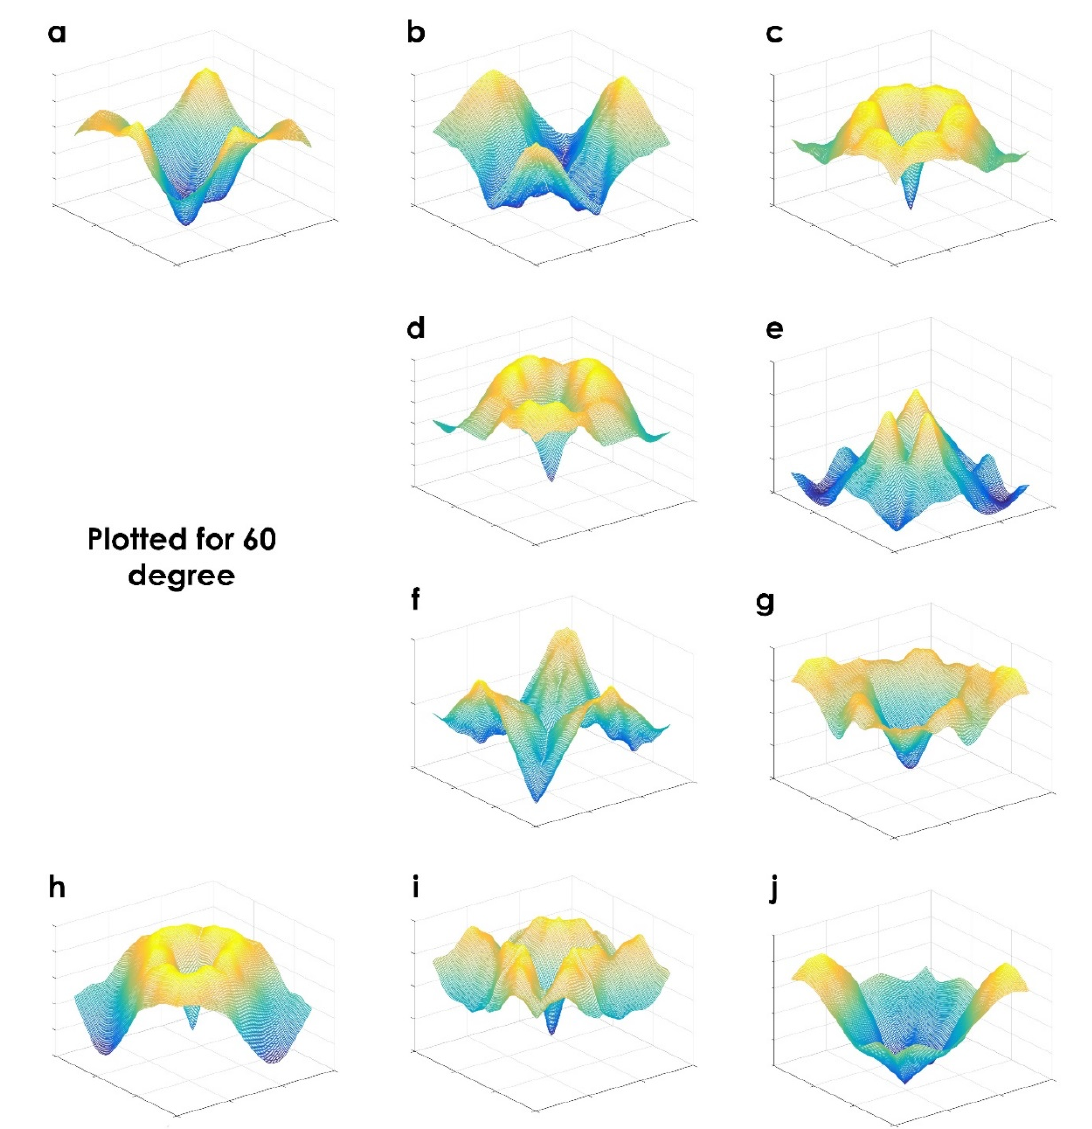
Figure 7. HOS cumulants: ( a ) normal, ( b ) complete endocardial cushion defect, ( c ) CCTGA, ( d ) my- ocardial tumor, ( e ) Ebstein’s anomaly, ( f ) hypoplastic RV, ( g ) hypoplastic LV, ( h ) tricuspid atresia, ( i ) mitral and tricuspid stenosis and ( j ) bald LA in TAPVC .